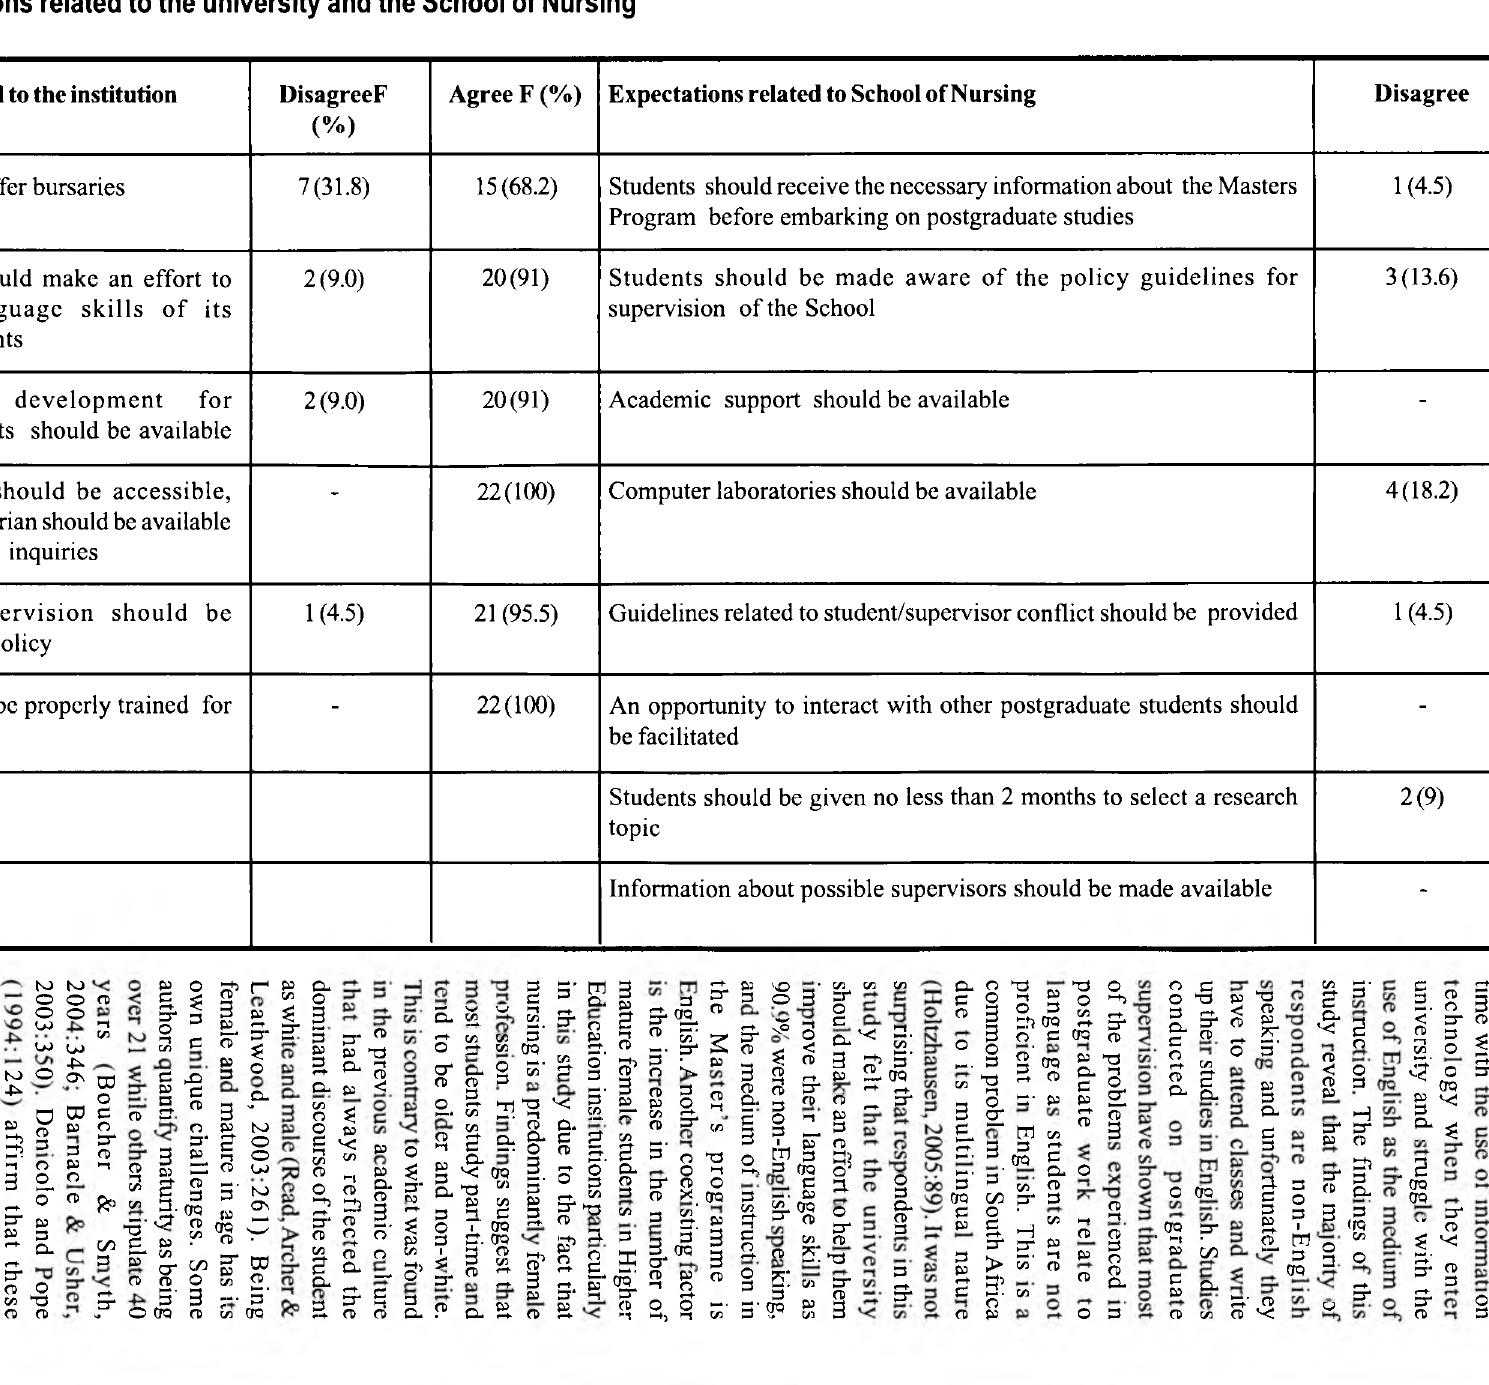
Table 2 Expectations related to the university and the School of